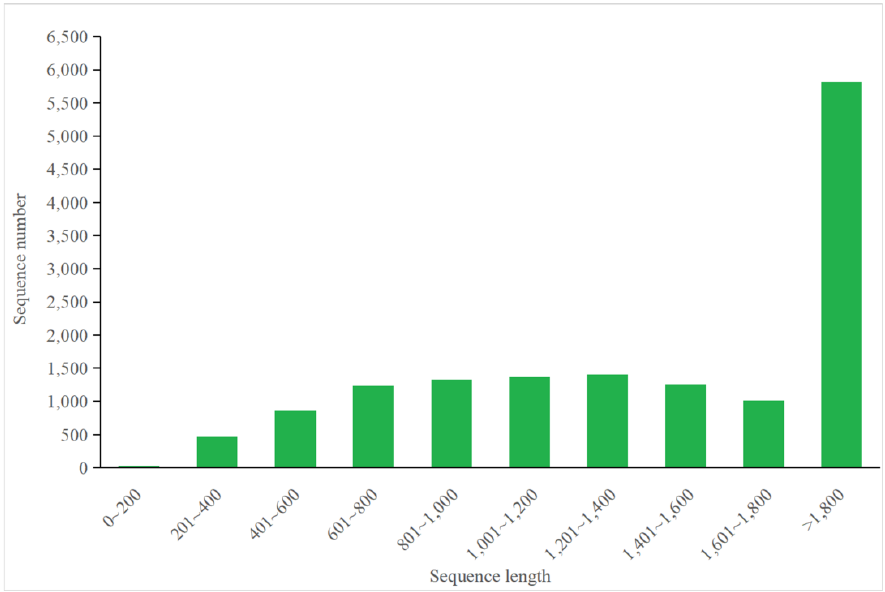
Figure 4. Length distribution of transcripts in P. tricornutum .